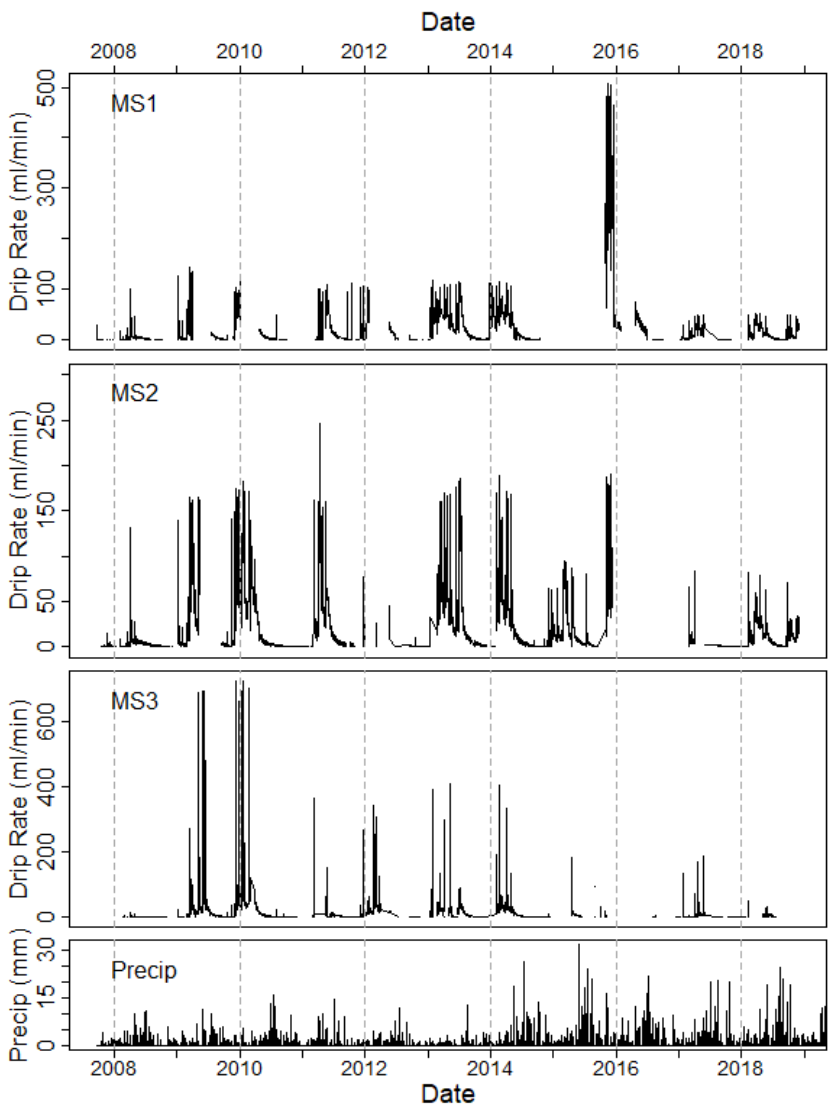
Figure 2. Time series of cave drip rates for MS1, MS2, and MS3 (mL/min) and hourly precipitation from CDO database for New River Valley Airport, Dublin, VA. Drip rates from 2008 to 2014 in l/d are included in [7]. Full dataset is available at [46]. Table 1. Annual precipitation [47] for New River Valley Airport, Dublin, VA,